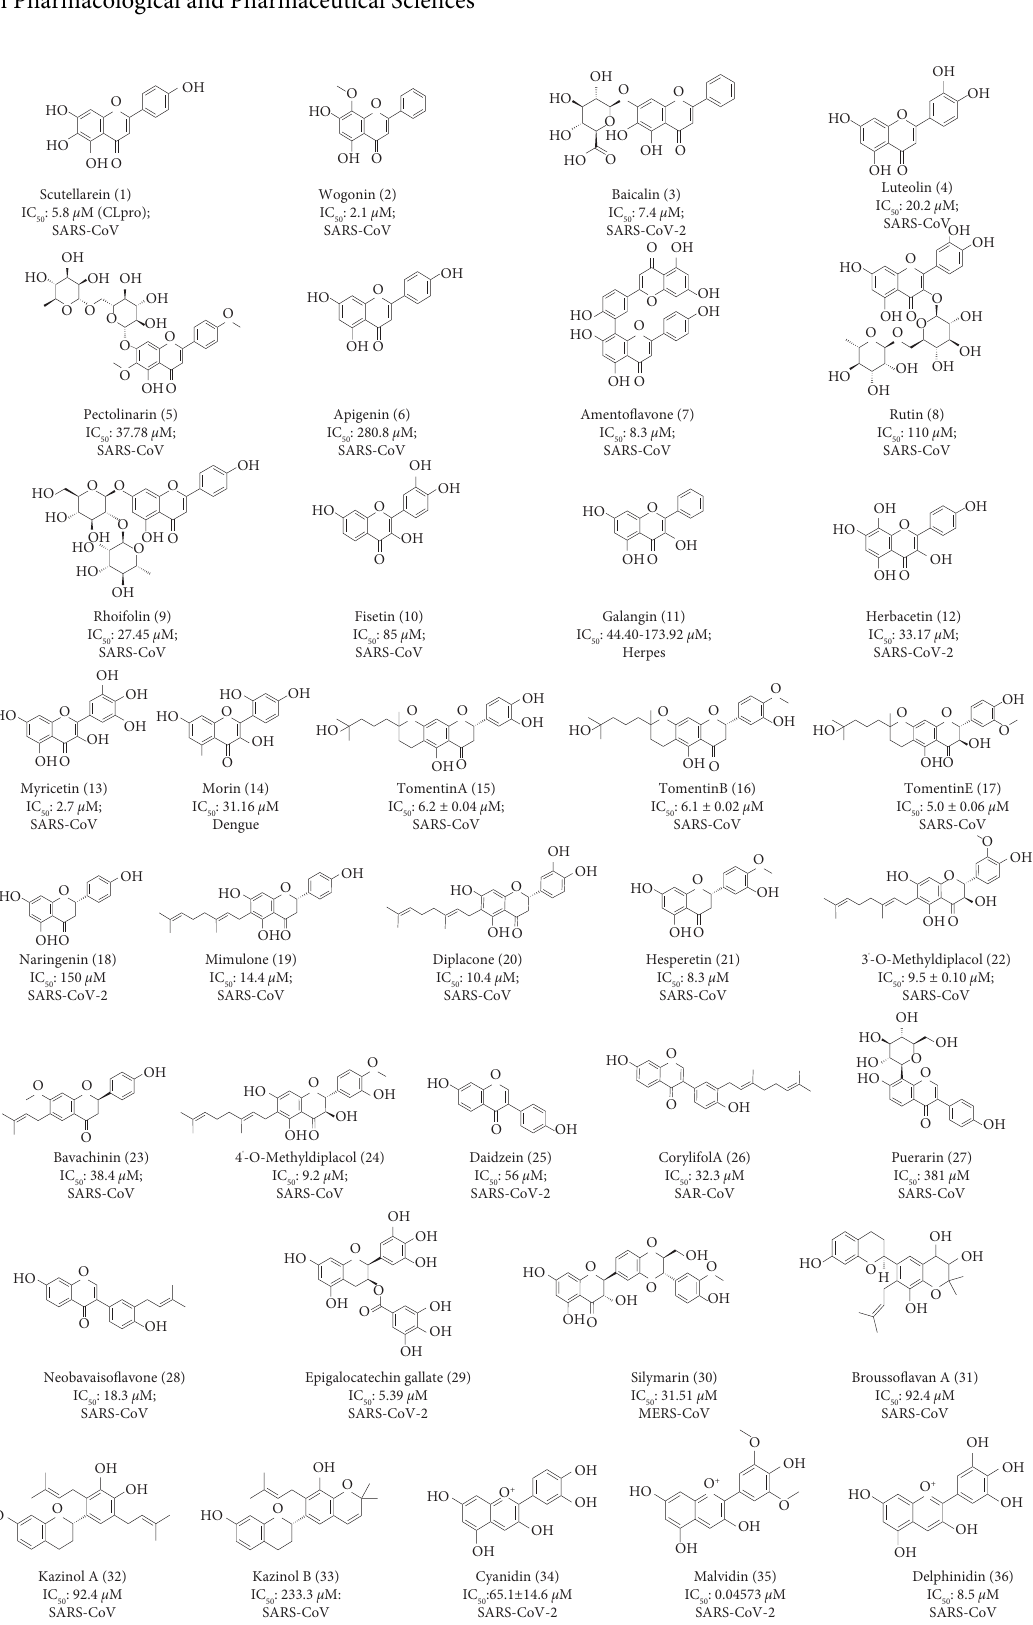
Figure 1: Chemical structures of selected antiviral favonoids with their IC 50 values against diferent viruses according to in vitro approach done in previous